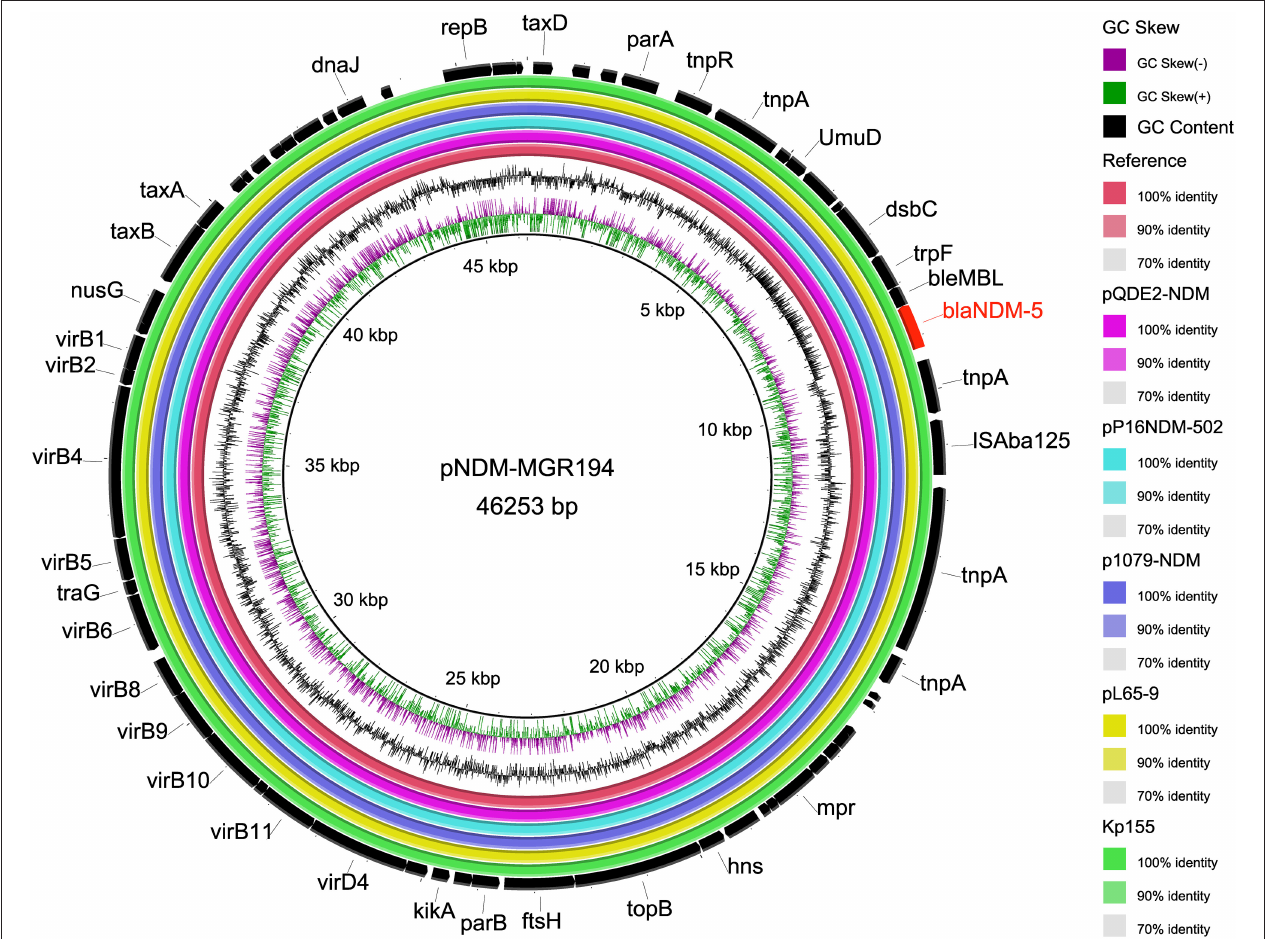
FIGURE 4 | Comparison of whole-genome sequences of plasmid IncX3 carrying bla NDM − 5 . Each ring represents an isolated strain. The internal ring is the reference sequence of NDM-5 carrying plasmid pNDM-MGR194 (46253bp, GenBank accession no. KF220657), and the outside rings are the other five plasmids, including Kp155 from this study. From inside to outside, the rings were derived from human (pQDE2-NDM, MH917280), dog (pP16NDM-502, MN701974), chicken (p1079-NDM, MG825384), and goose (pL65-9, CP034744).